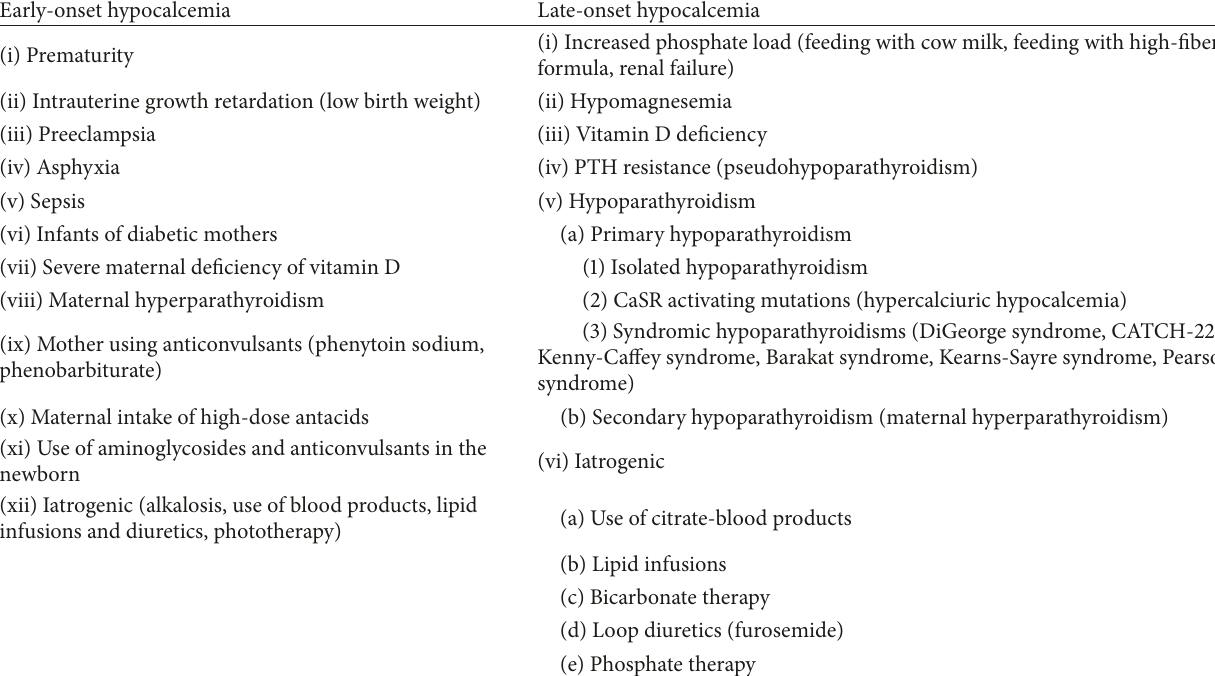
Table 1: Causes of early and late onset hypocalcemia in the newborn period and